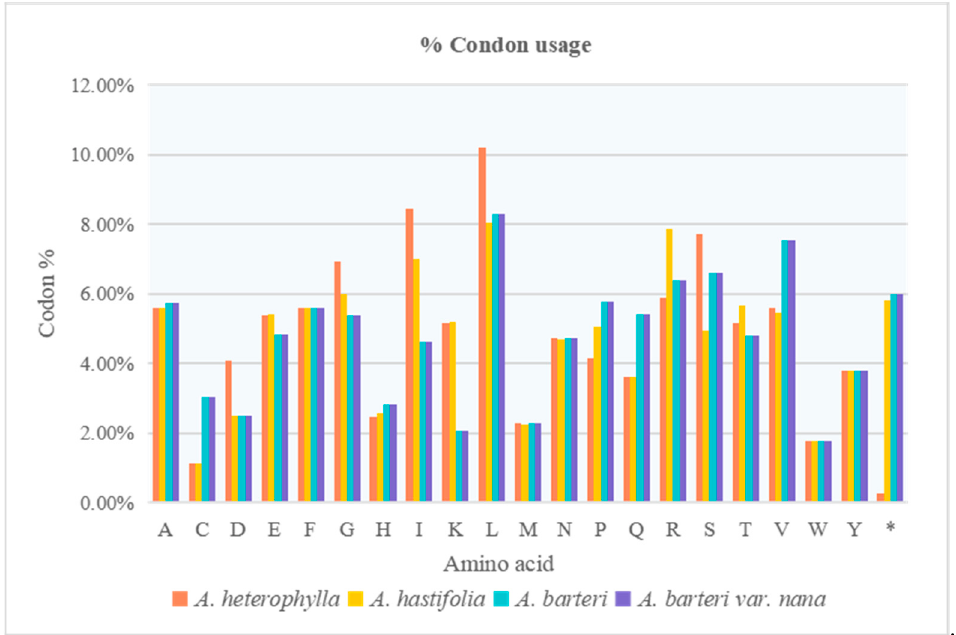
Figure 5. Codon Usage in four Anubias plastomes. * stop condon.